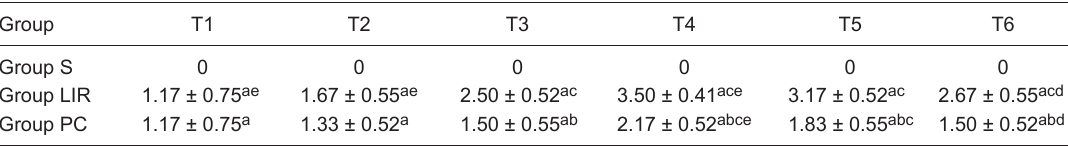
Table 1. Chiu’s pathological grading of the small intestine in the rat groups studied. Group T1 T2